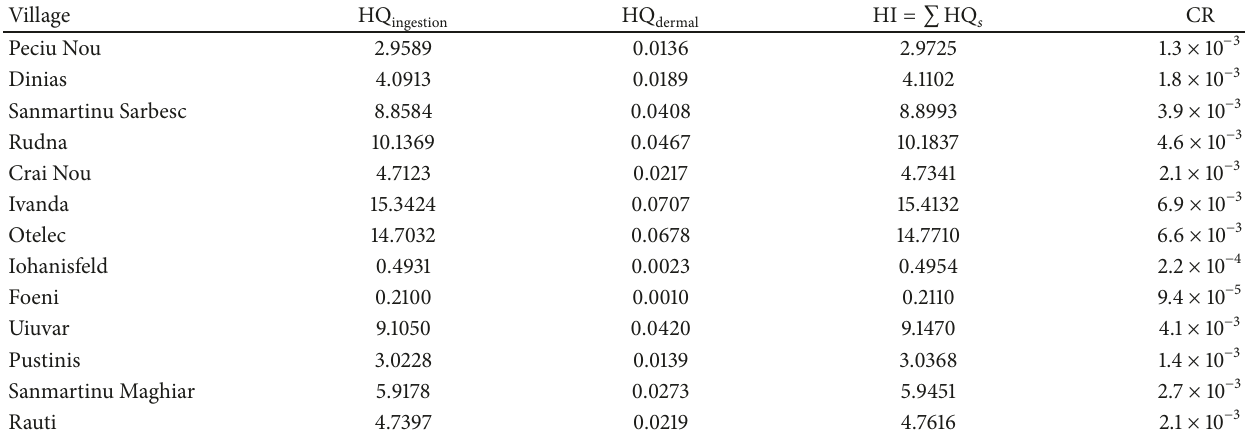
Table 2: Hazard quotient for As content in well water in each village from the study. ingestion